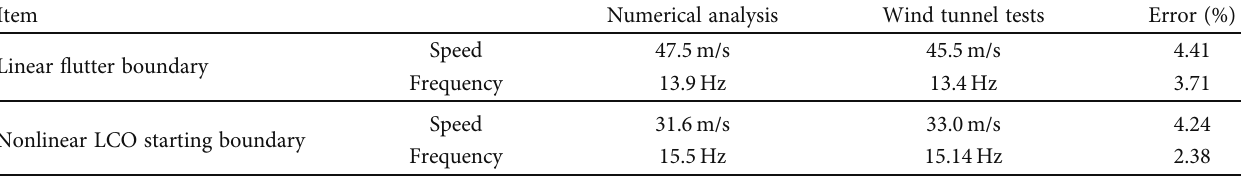
Table 6: Comparison on amplitude of the numerical analysis and wind tunnel tests.